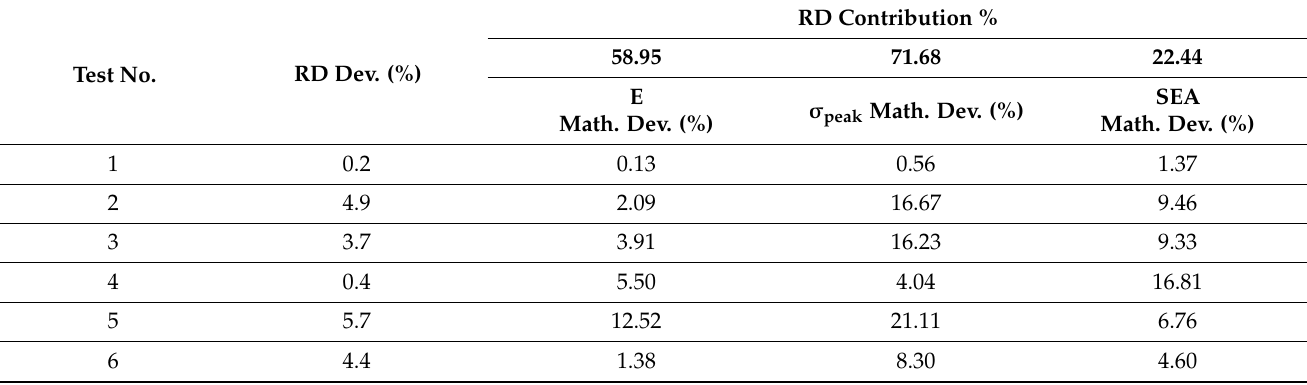
Table 16. Relationship between RD absolute percent deviation, RD contribution, and mathematical prediction absolute percent